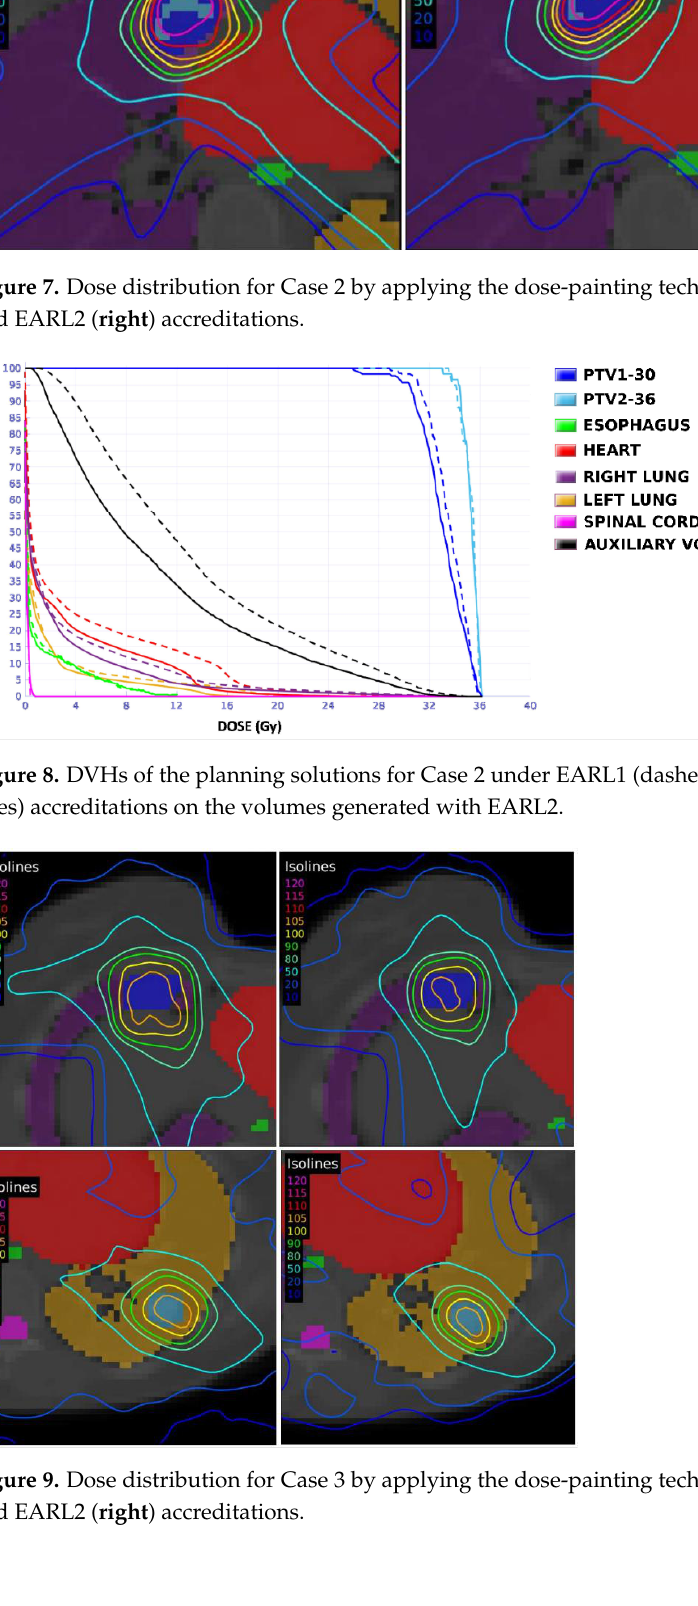
and EARL2 ( right ) accreditations.